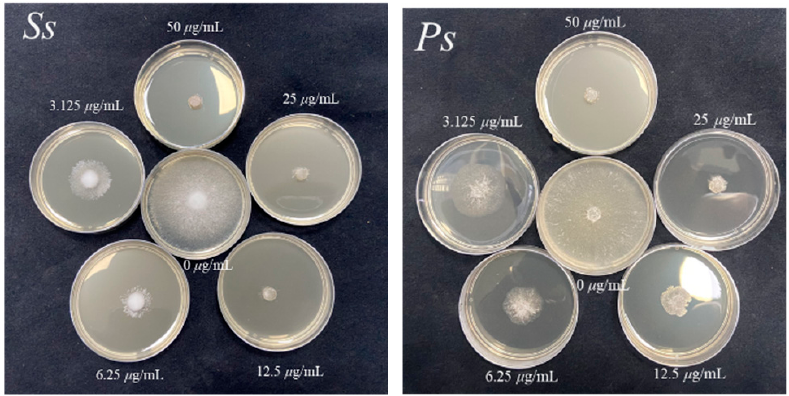
Figure 3. Antifungal activities of W12 against S. sclerotiorum (Ss) and Phomopsis sp. (Ps) in vitro.